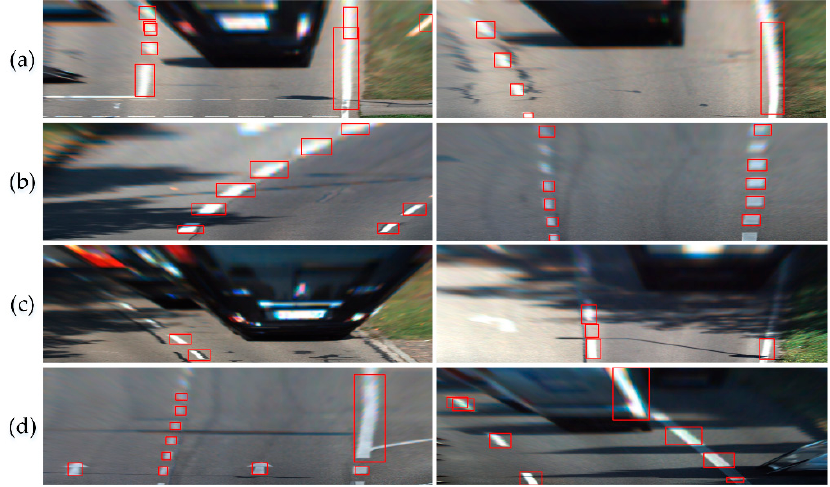
Figure 5. Detection results of the first-stage KITTI model on the KITTI dataset.